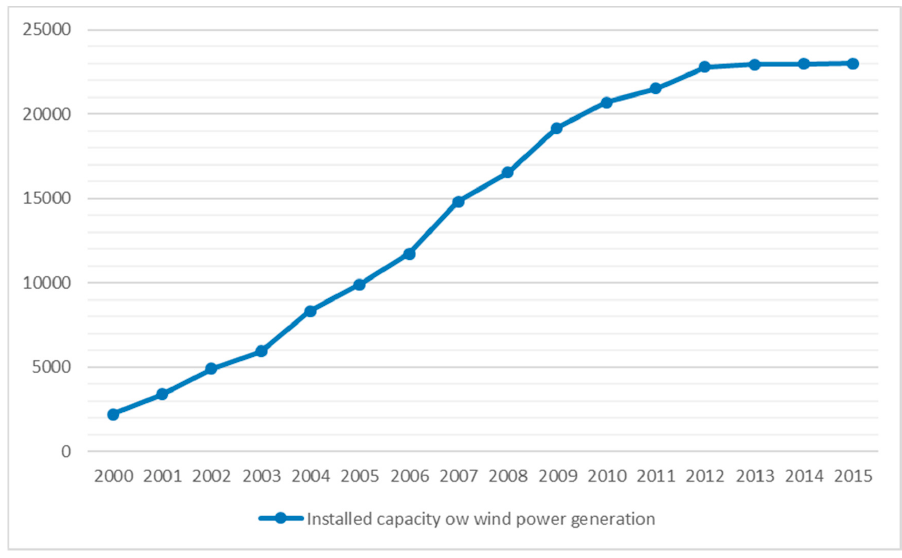
Figure 1. Installed capacity of wind power generation in Spain (2000–2015, TWh). Source: European Commission.